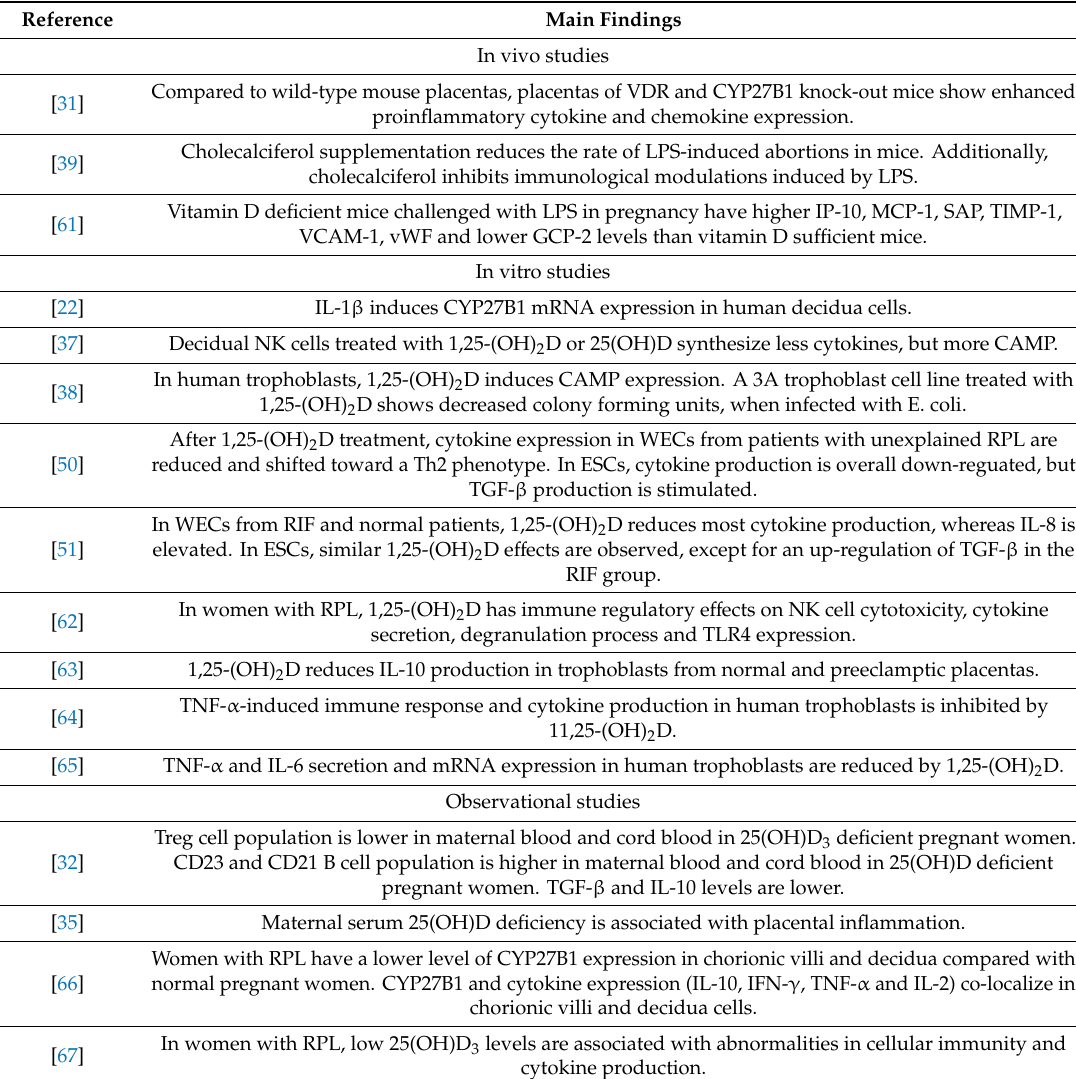
Table 1. Overview of studies focusing on the immunomodulatory e ff ects of vitamin D in reproductive tissues and reproductive